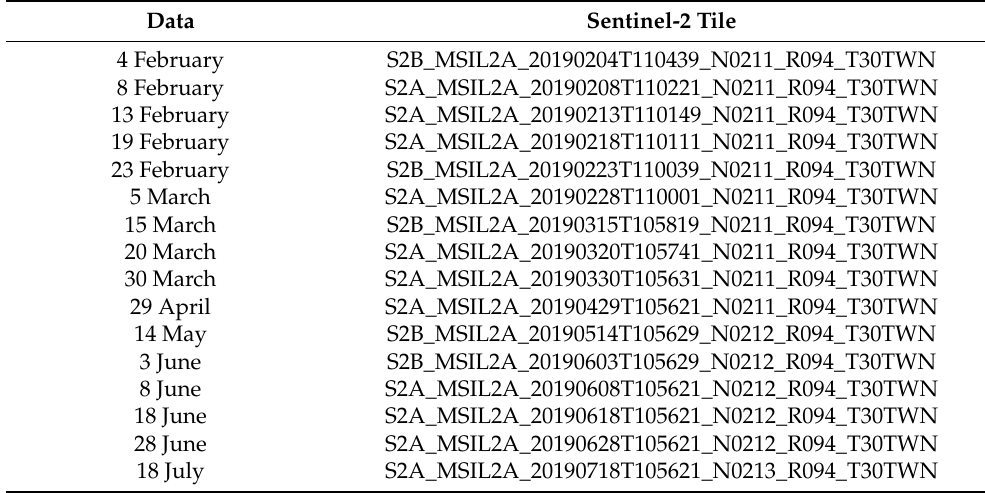
Table 3. Sentinel-2 T30TWN tiles used in this work and the captured